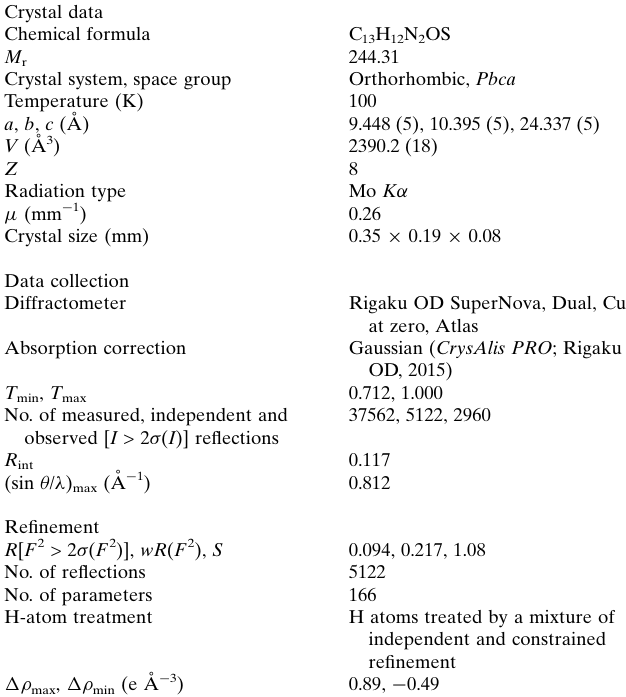
Figure 1 The molecular structure with displacement ellipsoids drawn at the 50% probability level. H atoms are drawn as circles of arbitrary size.